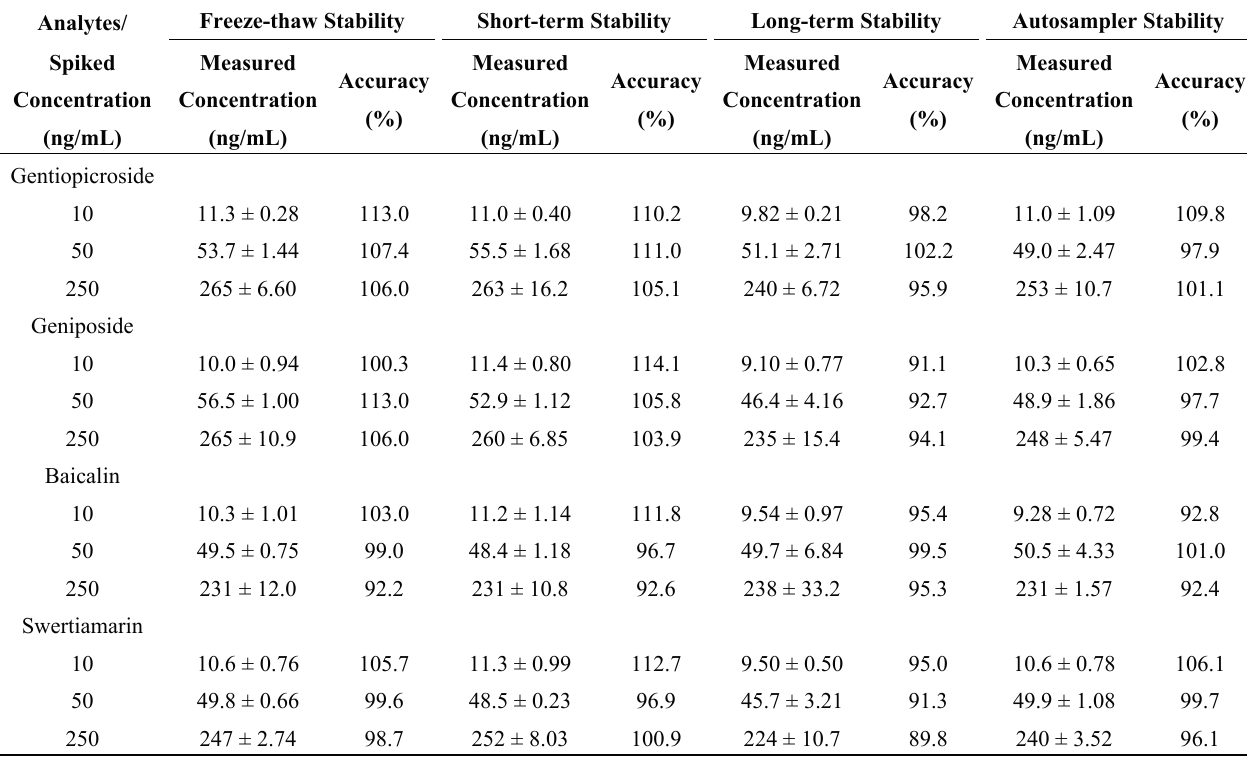
Table 4. Stability of gentiopicroside, geniposide, baicalin, and swertiamarin in rat plasma QC